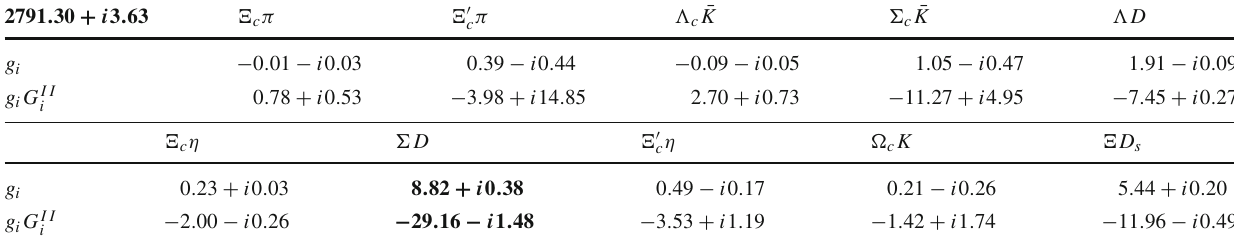
Table11 Thecouplingconstantstovariouschannelsand g i G II (all units are in MeV)